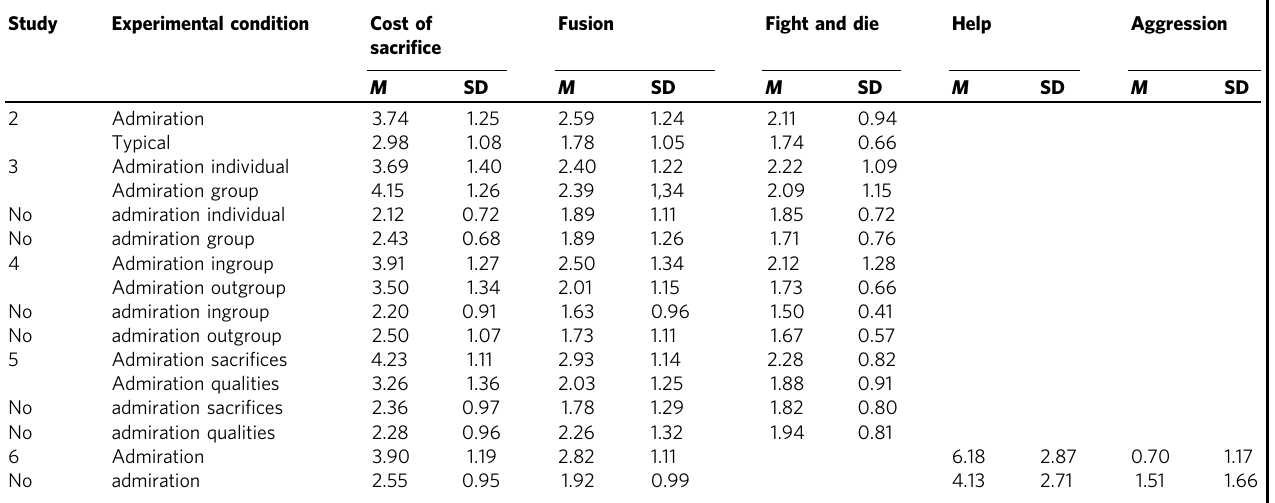
Table 3 Means and standard deviations per condition for Studies 2 – 6.